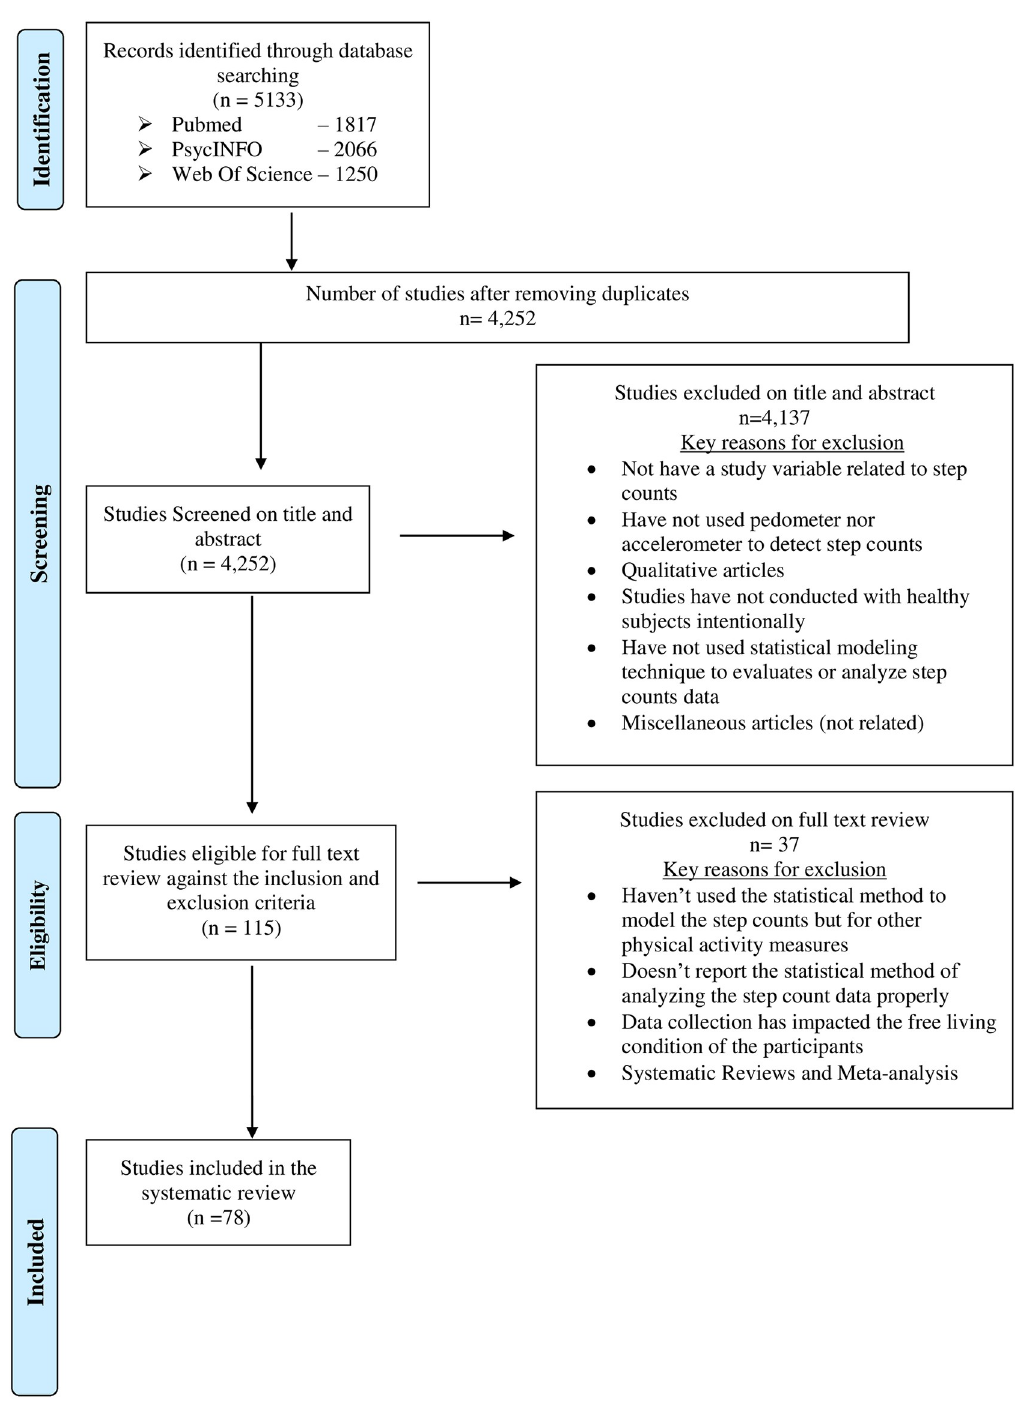
Fig 1. PRISMA flow